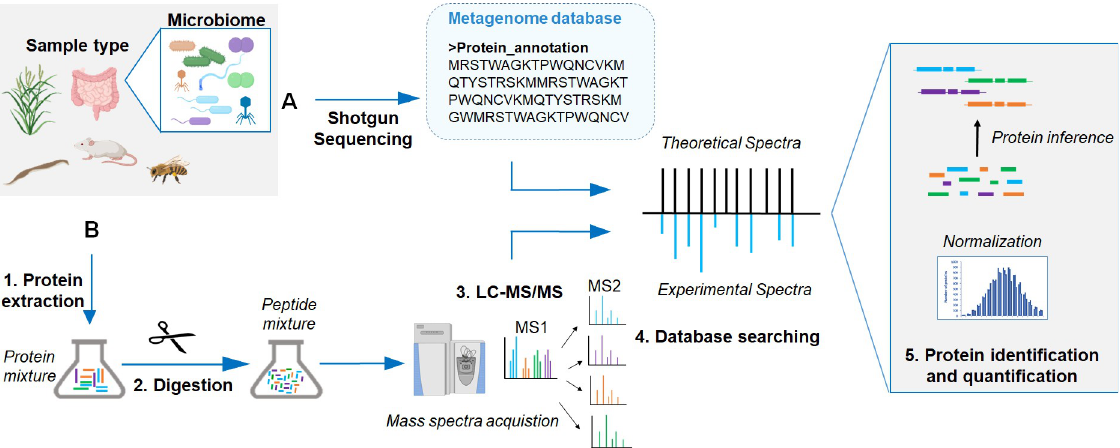
Fig 1. General workflow employed in metaproteomics experiments. (A) Metagenome shotgun sequencing can be used to generate the reference database for metaproteomics. (B) Metaproteomics workflow including generation of peptides and high-resolution MS analysis. LC, liquid chromatography; MS, mass